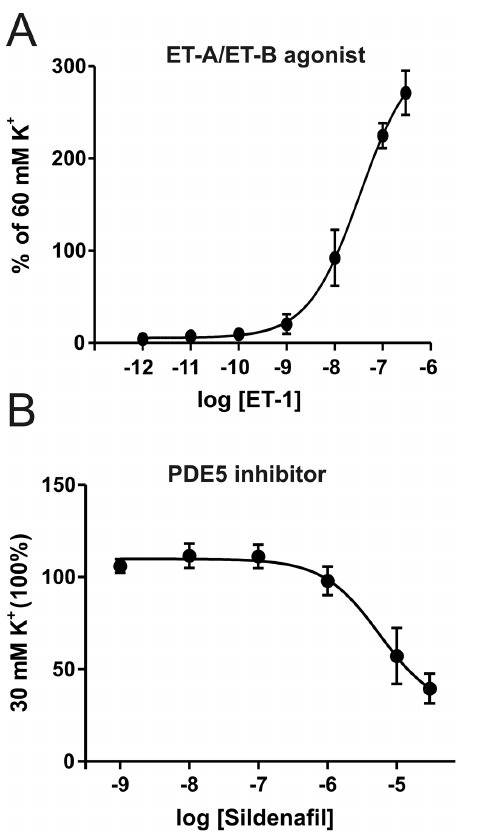
Figure 2. Characterization of responses to a known vasocon- strictor/dilator. A) MMA contraction in response to the ET-A/ET-B receptor agonist ET-1, 100% equals the contraction in response to 60 mM K + B) MMA relaxation in response to sildenafil a PDE5 inhibitor, 100% is set to be the pre-contraction with 30 mM K + . (n=5)